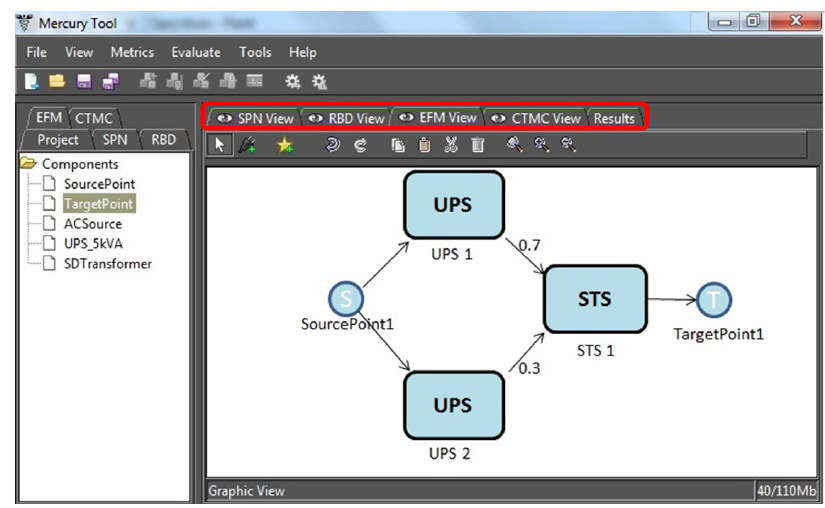
Figure 10. EFM example in the Mercury tool. STS, static transfer